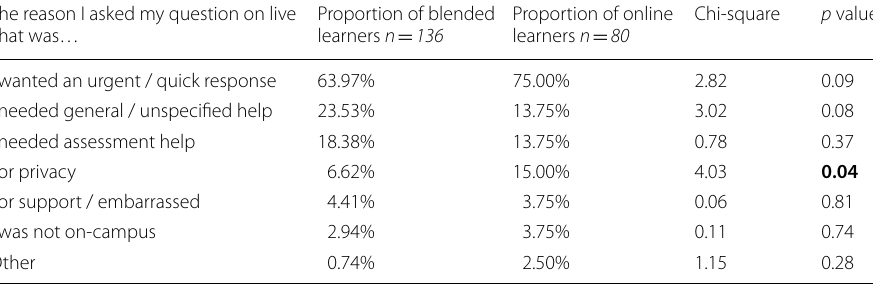
Bold indiactes significant value ( p <